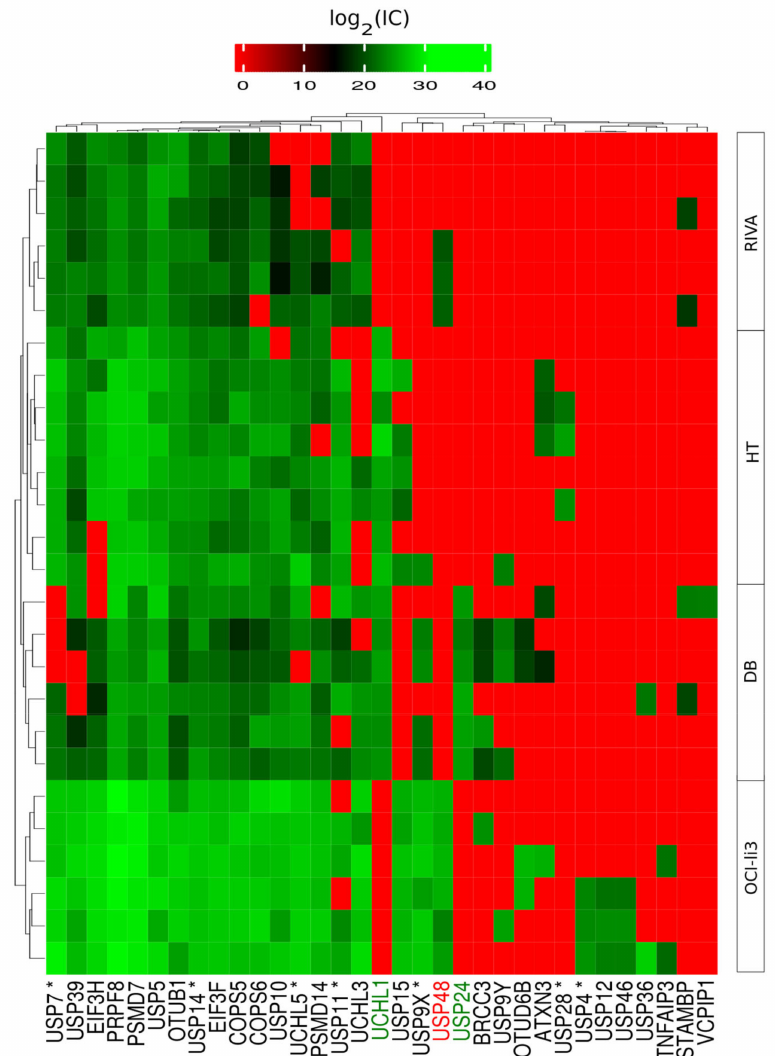
Figure 6. Heatmap of Log 2 ion counts for DUB proteins identified in DLBCL whole cells. (*) indicates DUBs for which inhibitors have been developed are marked with an asterisk. Protein names in green correspond to DUBs upregulated in GCB and in red upregulated in